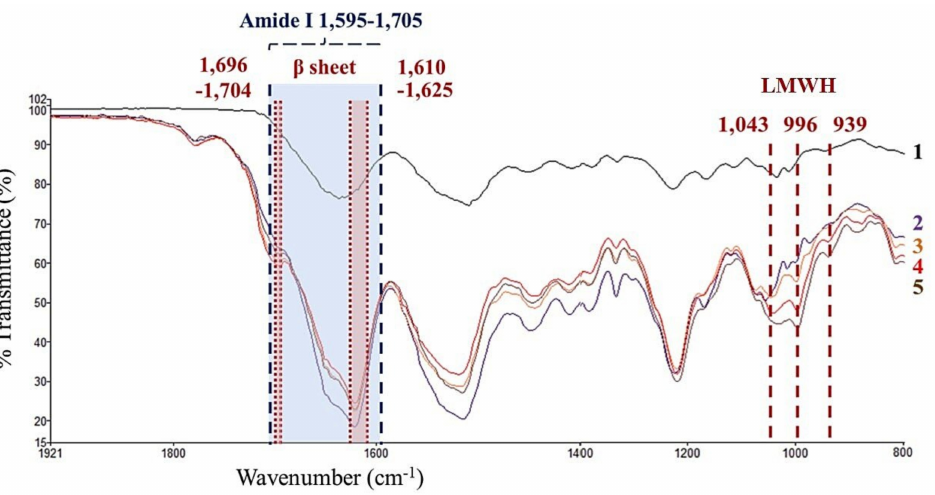
Figure 1. FTIR spectra of the samples including (1) non-crosslinked SF, (2) crosslinked SF, (3) 5, (4) 10, and (5) 15 Hep/SF films, respectively. The secondary structures of LMWH (peaks at 939, 996, and 1043 cm − 1 ), amide I (region 1595–1705 cm − 1 ), and β -sheet (regions 1696–1704 and 1610–1625 cm − 1 ) are shown. The data was presented in Thai Proceedings of the Graduate Research Conference (GRC) 2018, Thailand. Reprinted with permission from ref. [47]. Copyright 2022 Oraphan Anurukvorakun.